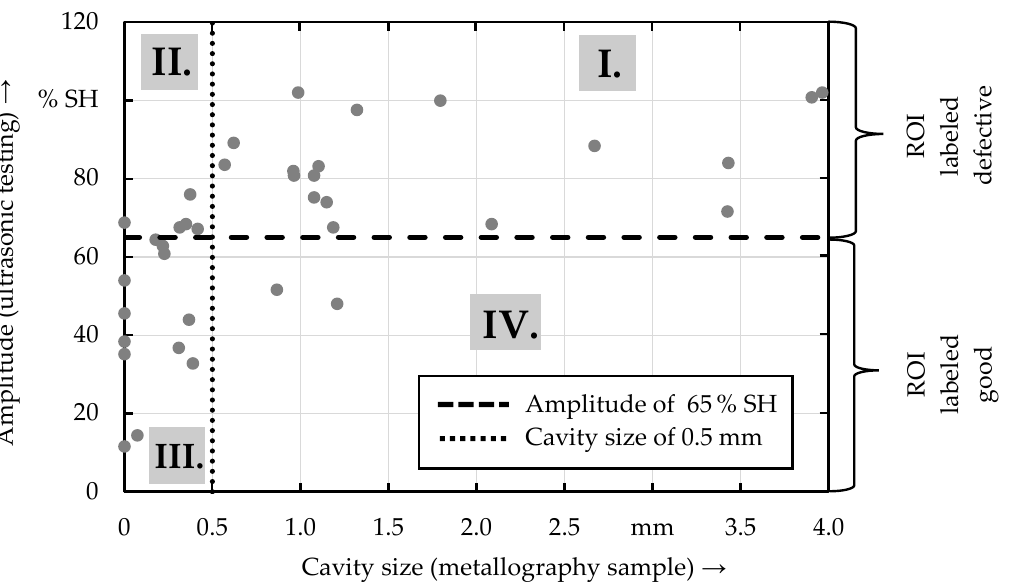
Figure 4. Dependence of the ultrasonic testing amplitude on the cavity size.